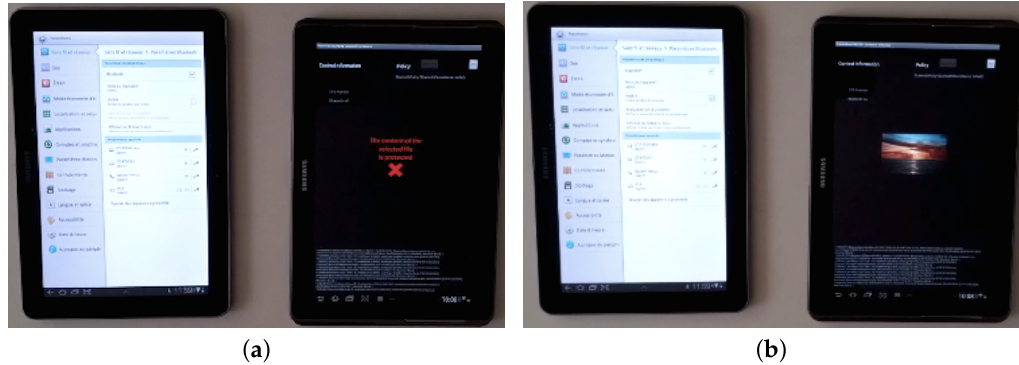
Figure 7. Policy based on Bluetooth device presence. ( a ) Access denied; ( b ) Access granted.